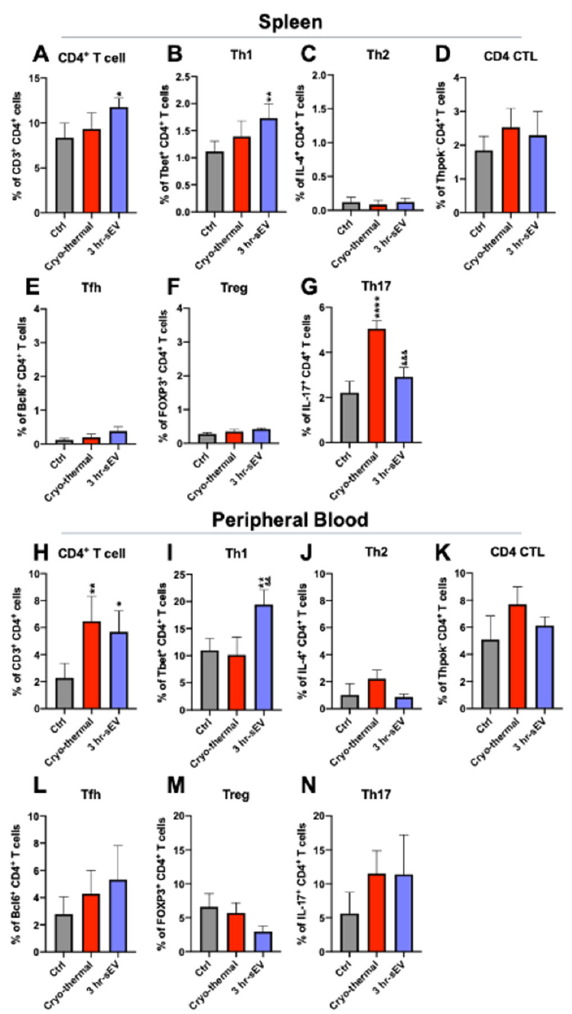
CD4 + T cells into Th1 cells on day 3 after treatment.